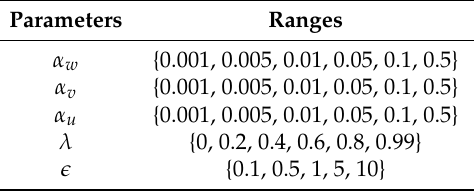
Table 1. Parameter Search